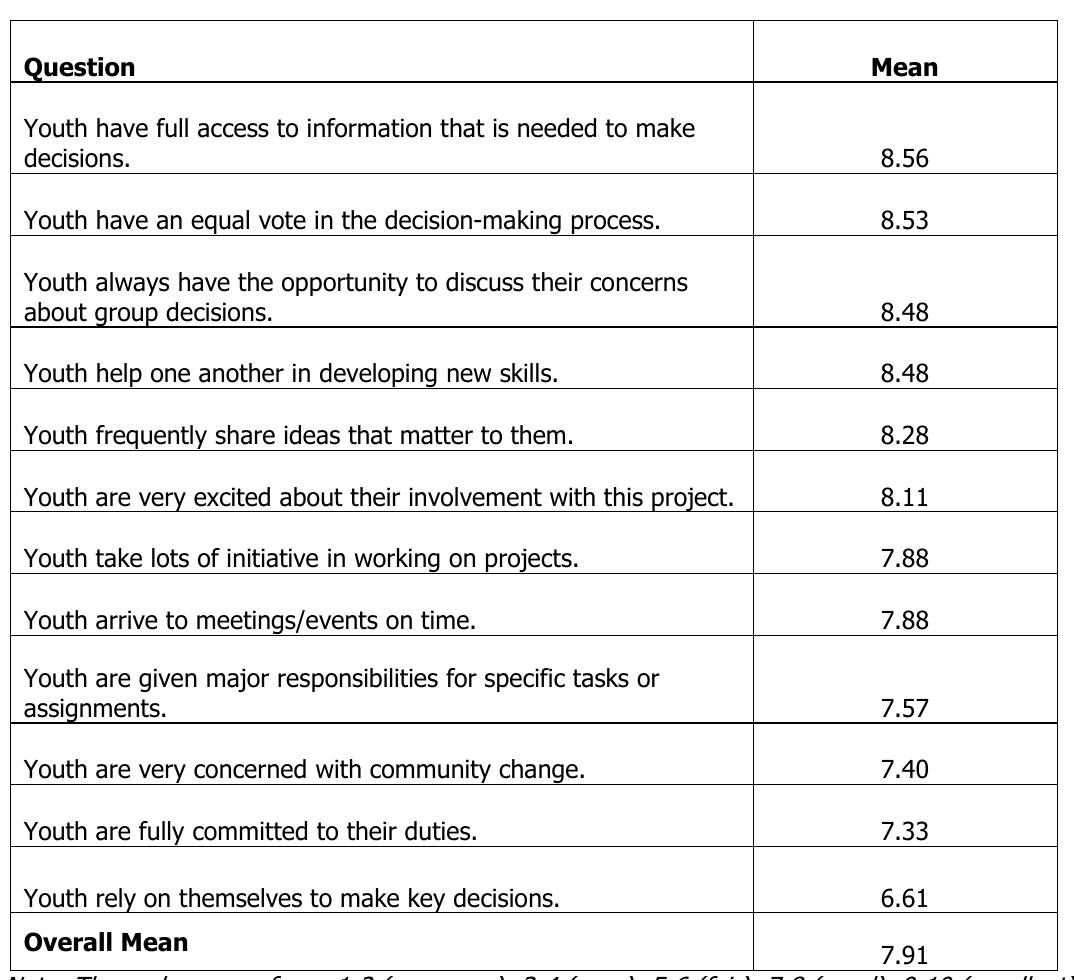
Scale item means and scale mean score for youth